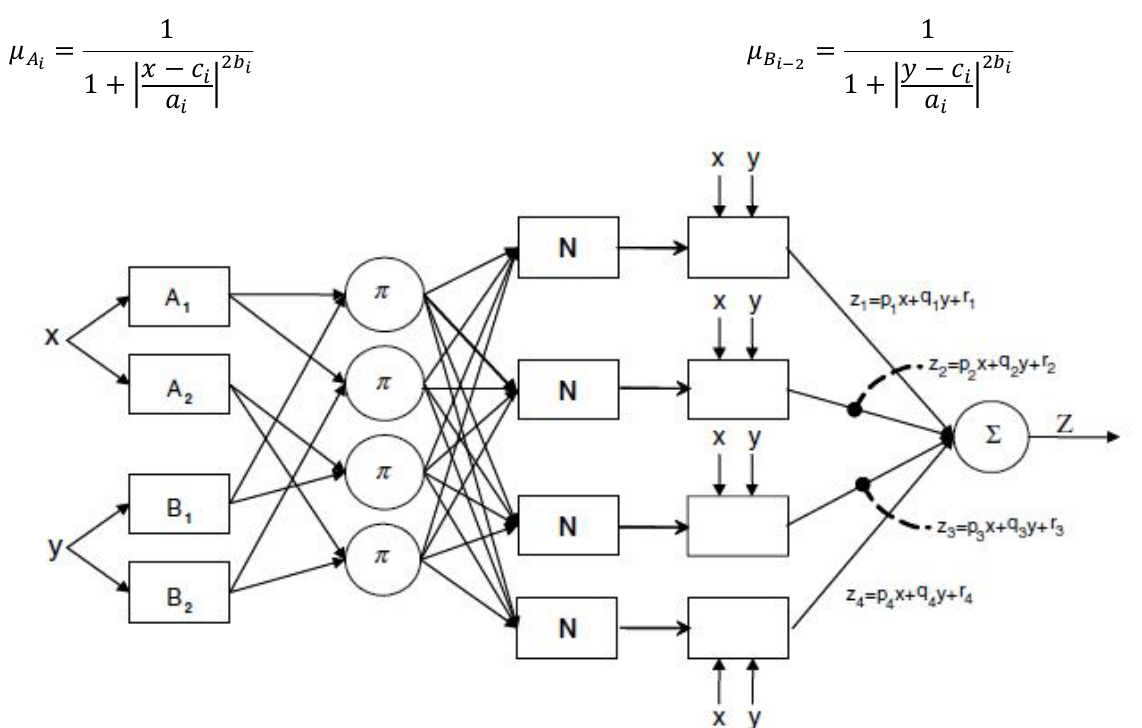
Fig. 1. ANFIS architecture for two-input Sugeno fuzzy model with four